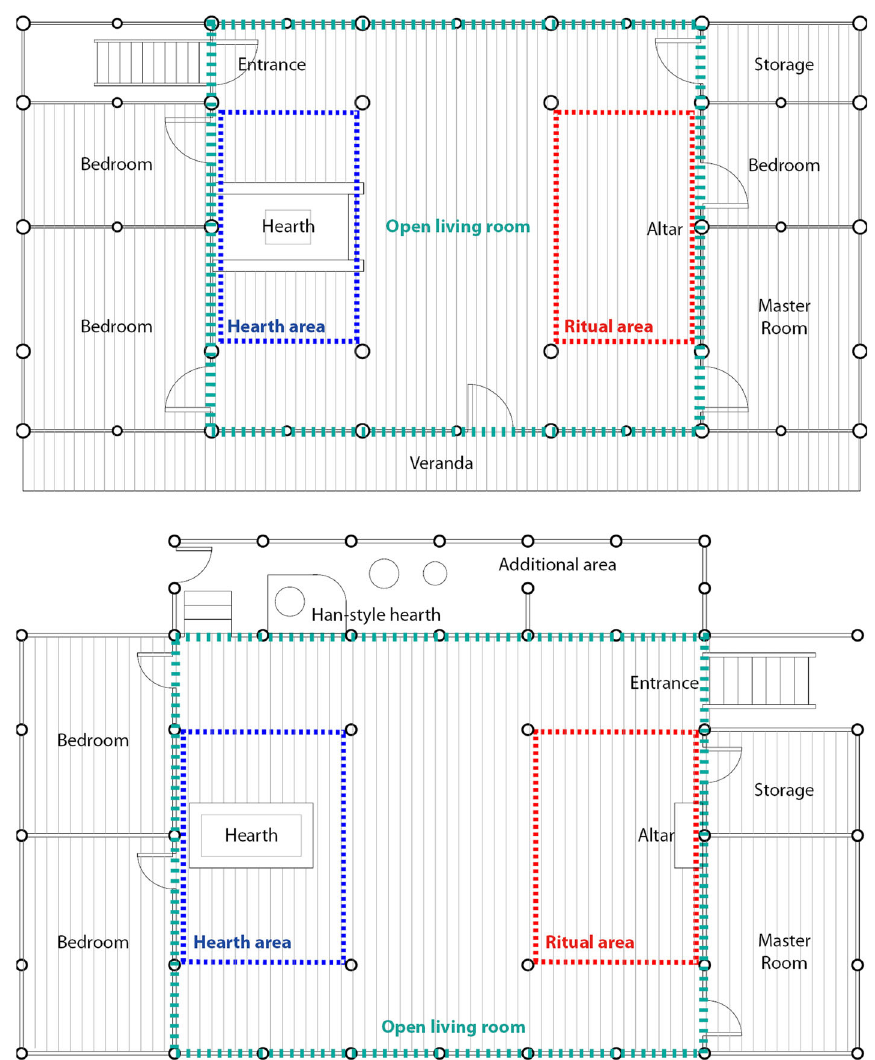
Fig. 7 The floor plans of S2 (upper) (source: Luo and Li 2016) and S3 (lower) (source: Lu 2004) show that the ancestral altar was always opposite the hearth with type